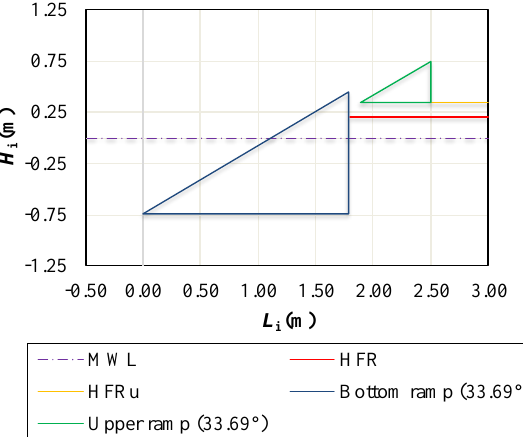
Figure 17. Ramps geometry of the case 40.